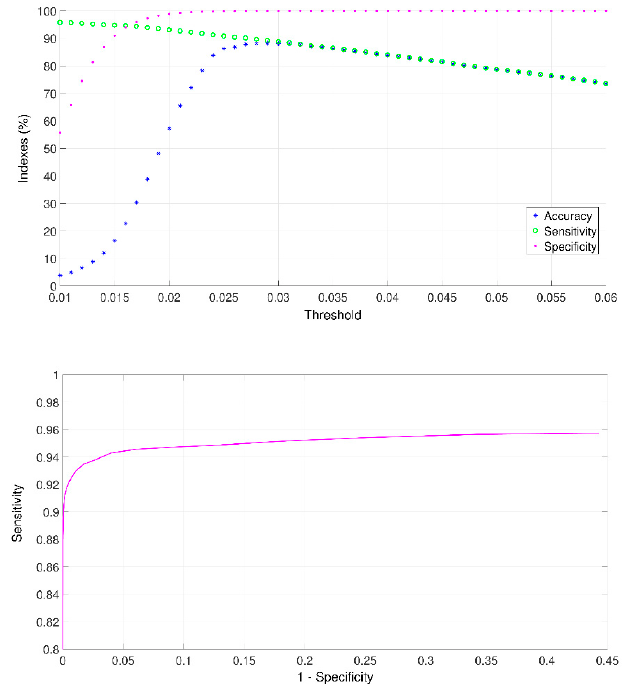
Figure 10. Performance indices of the developed automated crackle detector versus threshold value. Top : accuracy, sensibility and specificity indices. Bottom : Receiver operating characteristic (ROC) curve of the developed automated crackle detector. Results are for all simulated scenarios in Table 2.